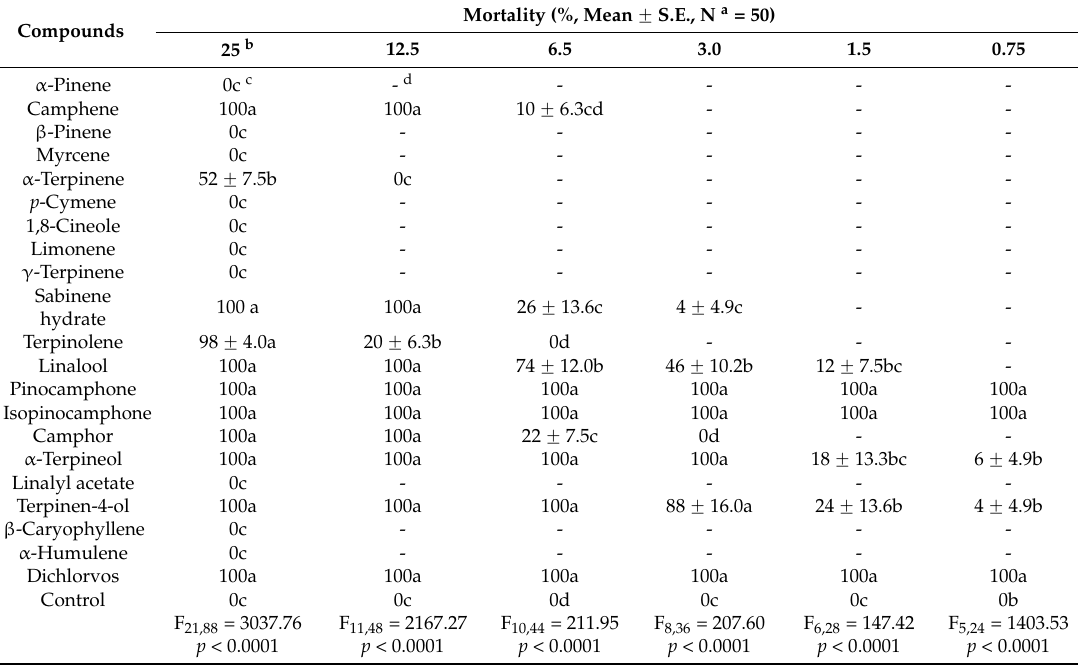
Table 3. Fumigant toxicities of constituents identified from active plant essential oils against adults of the rice weevil S. oryzae